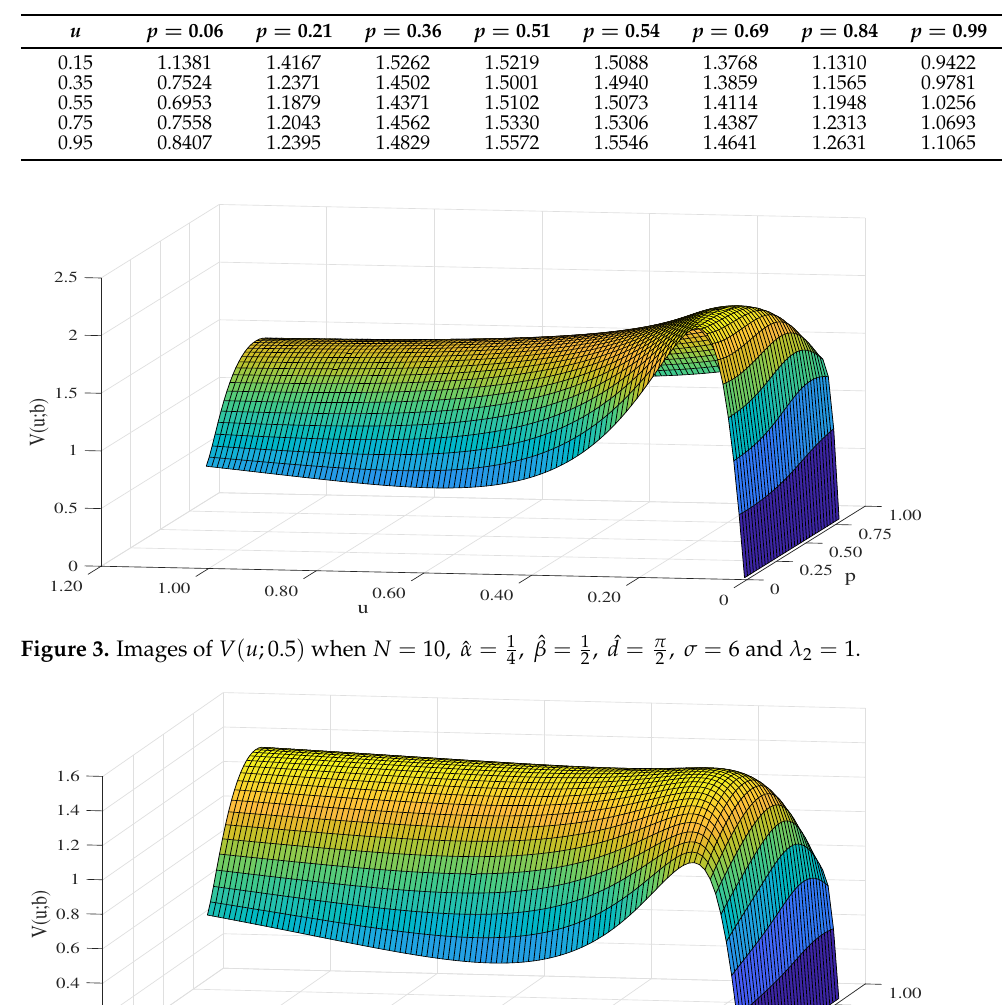
, ˆ β = 1 , ˆ d = π , σ = 6 and λ 2 = 2 2 4